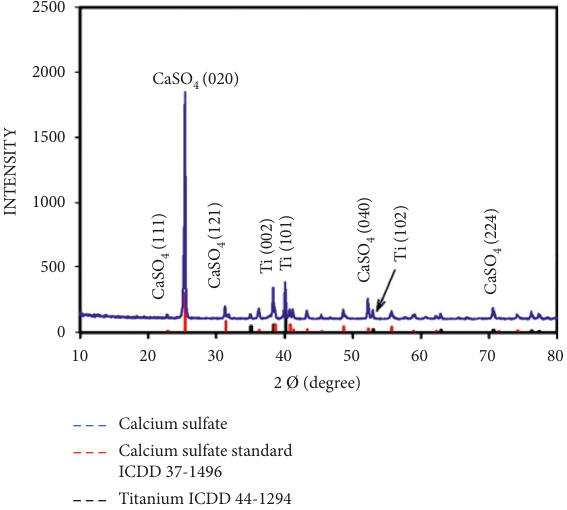
Figure 3: X-ray diffraction pattern of Cp Ti coated with nano calcium sulfate and PVA as a binding agent.